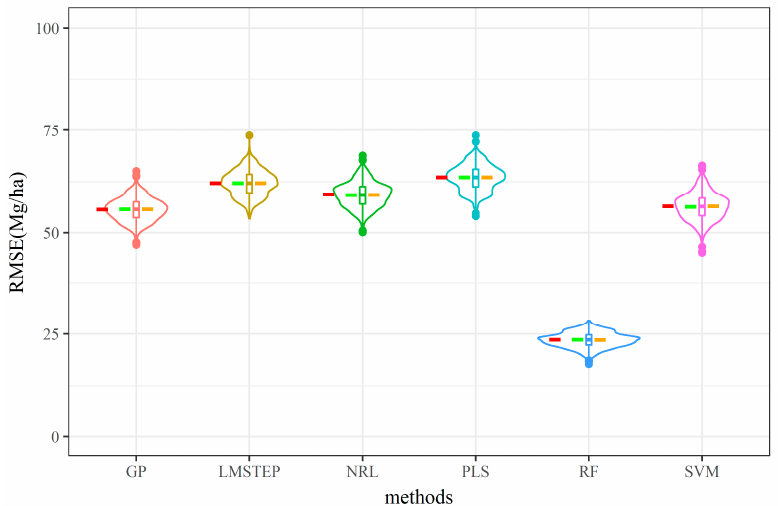
Figure 8. The distribution of RMSE values of the six prediction methods created with different cross-validation settings.